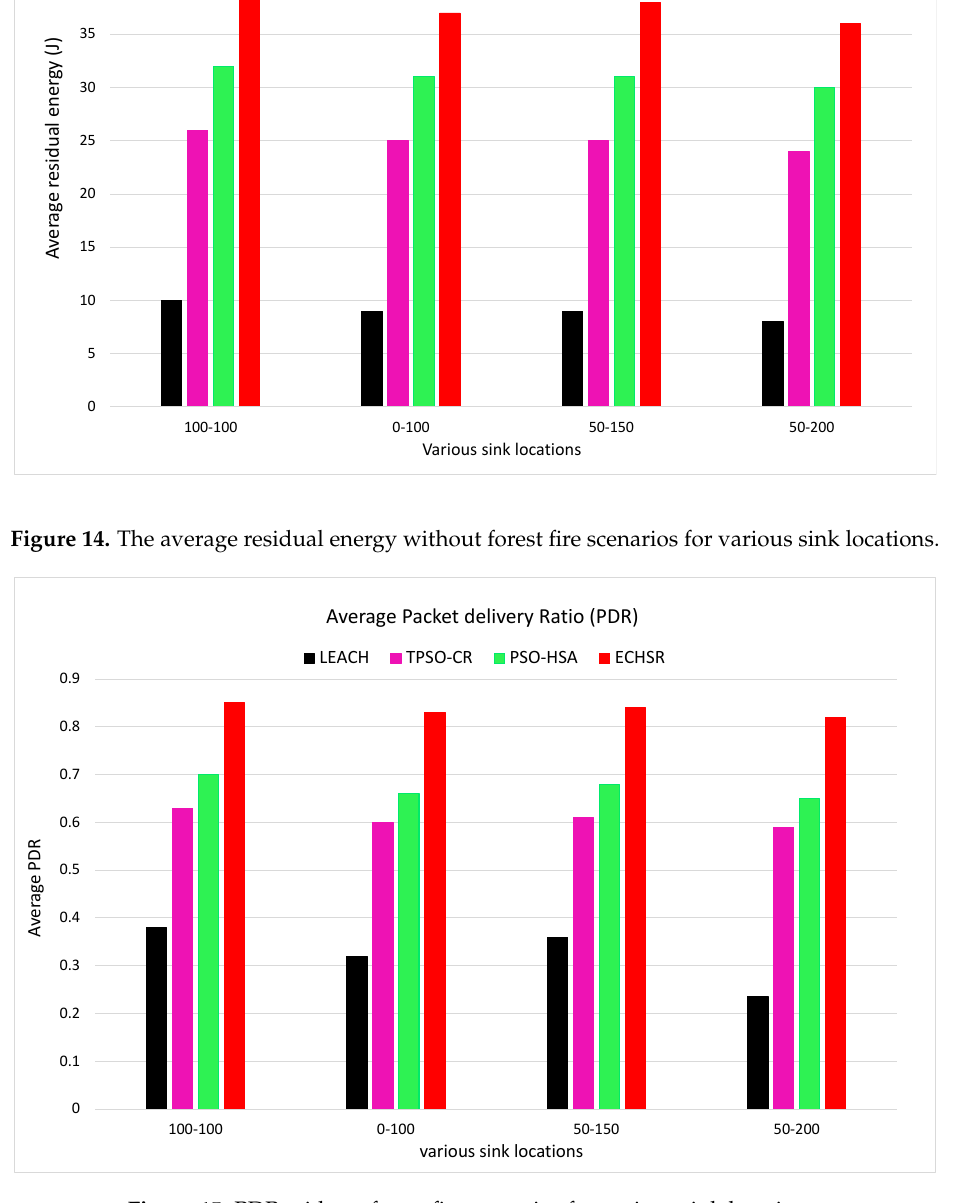
Figure 15. PDR without forest fire scenarios for various sink